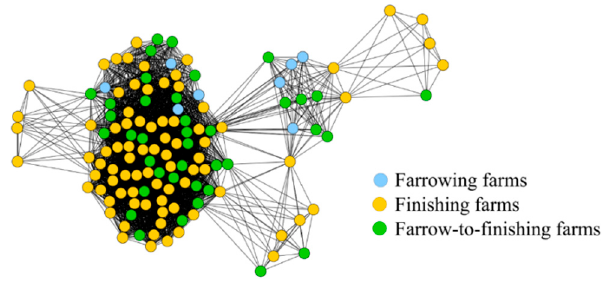
Figure 4. Projected feed supply network (FS projected ) of a pork supply chain in Northern Germany covering the observation period from 2013 to 2014. Isolated nodes are not illustrated.